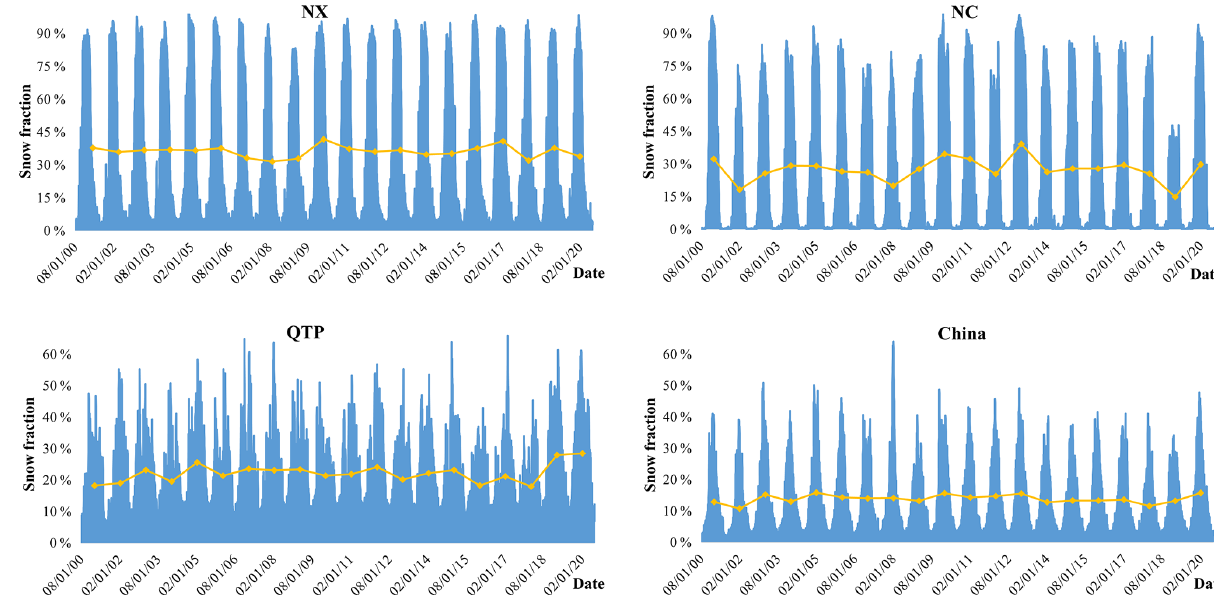
Figure 9. Daily average snow fraction of NX, NC, QTP, and China. Table 9. The cloud-removal effectiveness of STAR compared to Landsat NDSI maps under different simulated cloud conditions. Note that bold values indicate a significant degradation of the accuracy under the current cloud cover compared to the previous